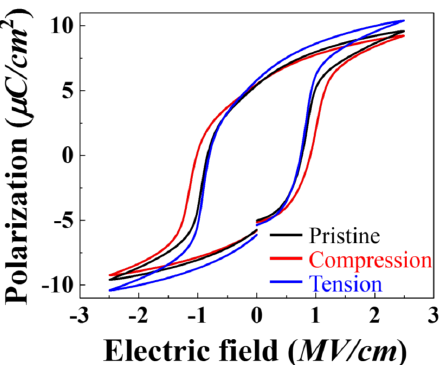
Figure 3. The PE hysteresis loop of PVDF at pristine and after applying 10 7 tensile and compressive stressed. The initial remnant polarization of 5.48 μm/cm 2 at pristine PVDF remains almost identical